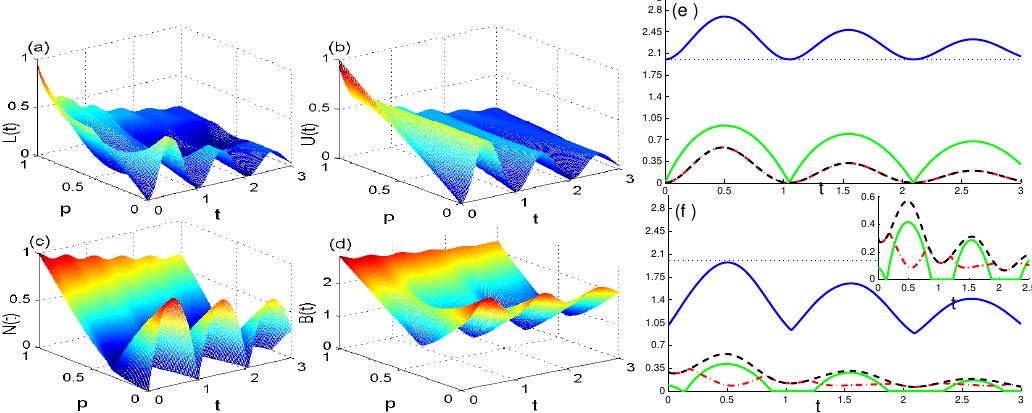
Figure 4. The 3D-evolution of L ( t ) in ( a ), U ( t ) in ( b ), N ( t ) in ( c ) and B ( t ) in ( d ) as functions of the time and the purity indicator p ∈ [ 0,1 ] for χ z = 0.5, ∆ = 1.5, J x = J z = 2 and γ = 0.4. The 2D-evolution of L ( t ) (dashed plots), U ( t ) (dashed dotted plots), B ( t ) (upper solid plots) and N ( t ) (solid plots) for p = 0 in ( e ) and p = 0.3 in ( f ).